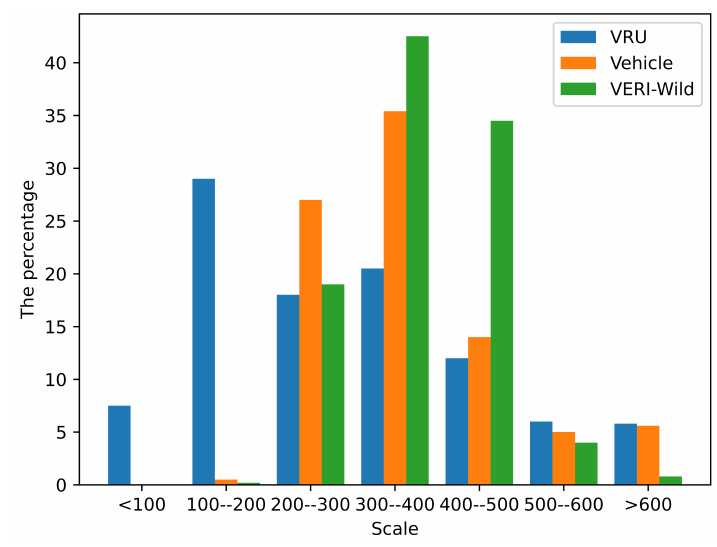
Figure 5. The distribution of vehicle scales.